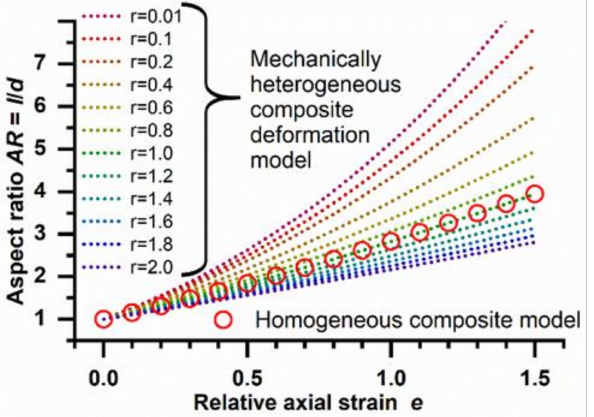
Figure 2. Graphical illustration of the impact of the ratio r of the E moduli of the particulate inclusion and the film matrix on the predicted AR of particles at different relative axial strains e (dotted lines; mechanically heterogeneous composite model according to Equation (2)). At r = 1, data match with the deformation model for a mechanically homogeneous composite (circles; see Equation